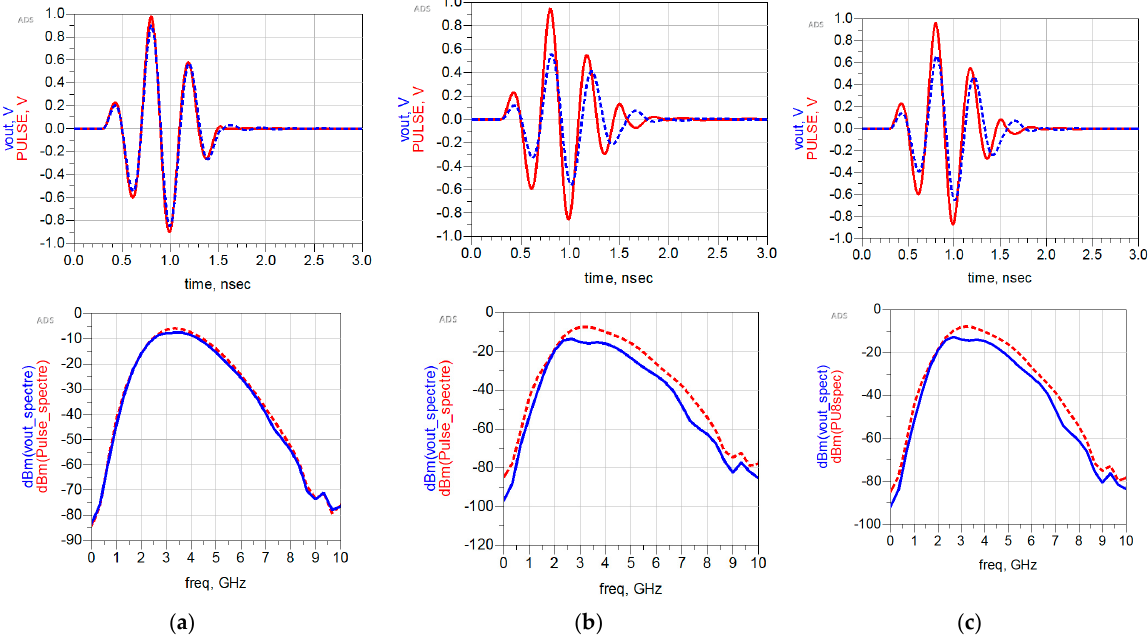
Figure 19. ( a ) The output voltage of the antenna equivalent circuit connected to 377 Ohm load; ( b ) the output voltage of the antenna equivalent circuit connected to a 50 Ohm load; ( c ) the output voltage of the antenna equivalent circuit connected to a 75 Ohm load.